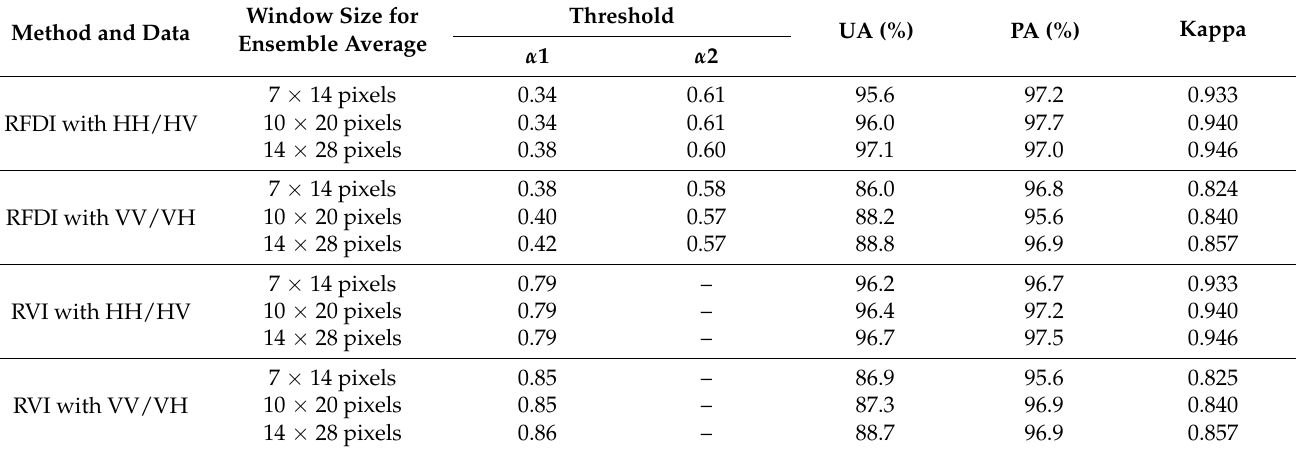
Table 7. Forest classification performance with vegetation indices at Rio